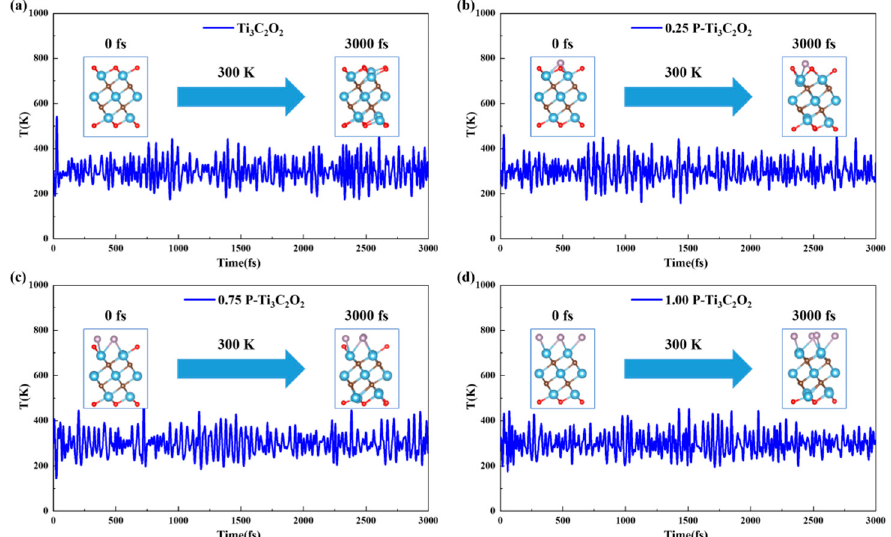
Figure 9. Ab initio molecular dynamics (AIMD) verification: ( a ) AIMD of Ti 3 C 2 O 2 at 300 K of canonical ensemble (NVT ensemble); ( b ) AIMD of 0.25 P-Ti 3 C 2 O 2 at 300 K of NVT ensemble; ( c ) AIMD of 0.75 P-Ti 3 C 2 O 2 at 300 K of NVT ensemble; ( d ) AIMD of 1.00 P-Ti 3 C 2 O 2 at 300 K of NVT ensemble; the illustrated structure shows the initial and final structural sketch.